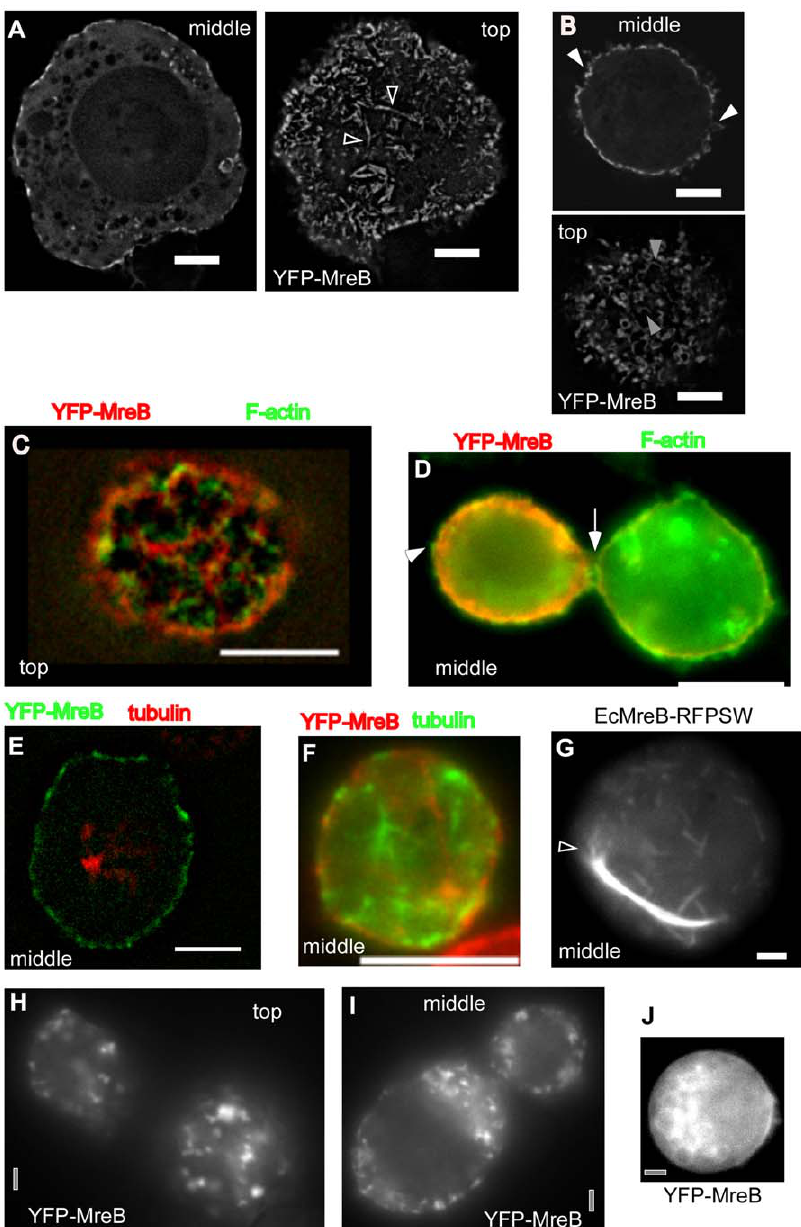
Figure 1. Expression of YFP-MreB or mutant versions in S2 cells. A) Wild type YFP-MreB filaments, shown are a middle plane and top plane of a Z-stack. Triangles indicate bundles of filaments from which a single filament (or thin bundle of filaments) emanates. B) Middle and top planes of a 3D deconvoluted Z-stack of a cell expressing wild type YFP-MreB. C–D) Immunofluorescence of cell expressing YFP-MreB, using phalloidin as stain for actin filaments. Triangles indicate positions of actin filaments that lack any detectable YFP-MreB fluorescence. E–F) Immunofluorescence of cell expressing YFP-MreB, using anti Drosophila tubulin antiserum to stain for tubulin filaments. G) E. coli MreB (with an internal RFP) expressed in S2 cells, shown is the middle plane. Triangle indicates MreB filaments extending from the end of a filament bundle. H–I) Cells were depleted for ATP by the addition of FCCP, H–I) 20 min after addition, J) 90 min after addition (middle plane is shown). White bars 2 m m (A,B, G) or 5 m m (C–F) respectively, grey bars 2 m